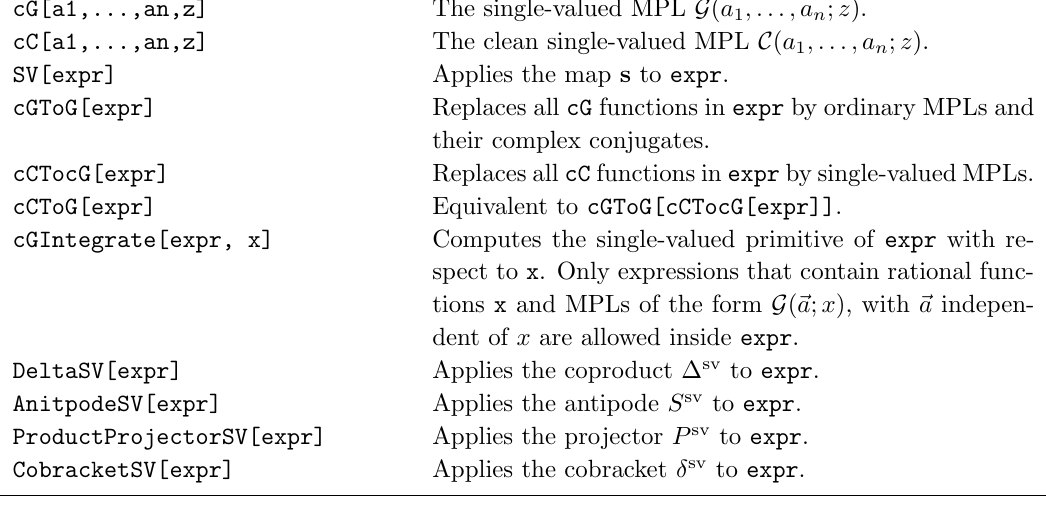
Table 8 . Manipulating expressions